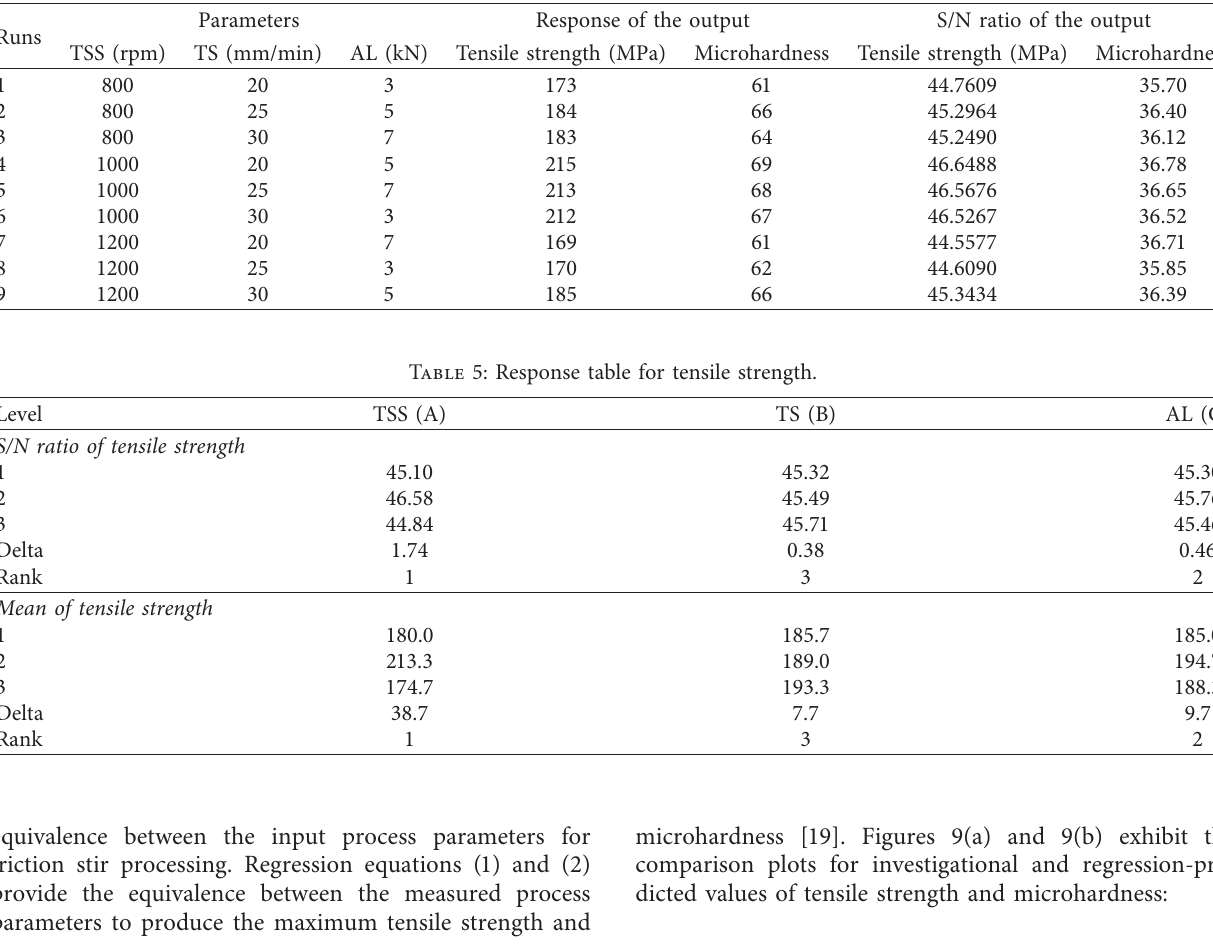
Table 4: Estimated S/N ratio values.